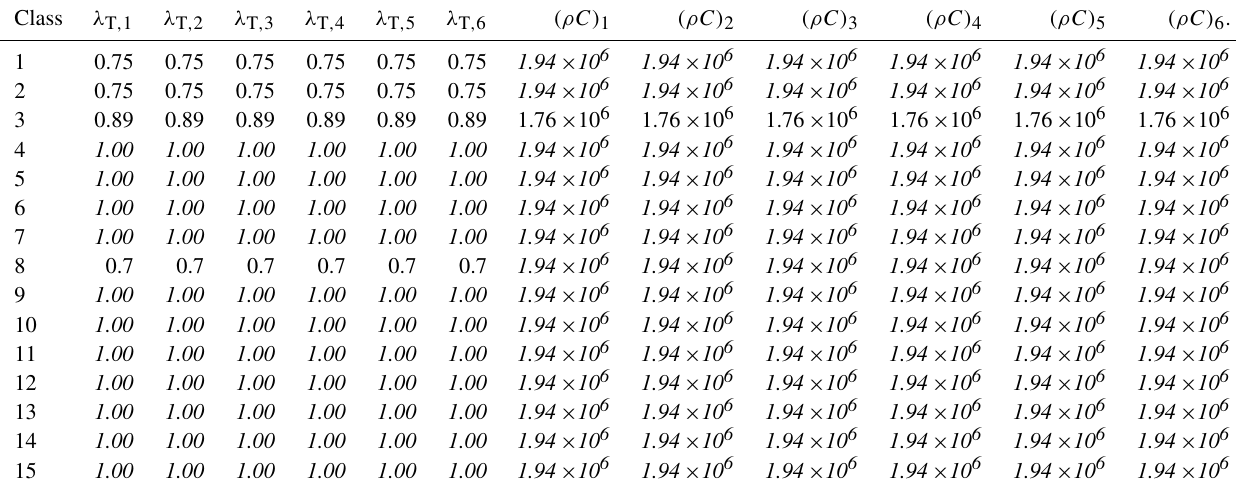
Table A4. Thermal conductivity λ T , i (in Wm − 1 K − 1 ) and heat capacity (ρC) i (in JK − 1 ) of subsurface layer i according to pavement_type classification. The italic values are preliminary. The subscript indicates the respective pavement layer. The pavement layers are defined between depth: 0–0.01, 0.01–0.03, 0.03–0.07, 0.07–0.15, 0.15–0.3 and